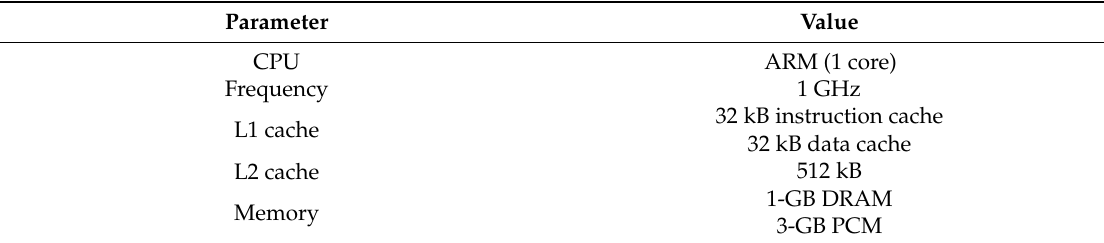
Table 1. System configuration.